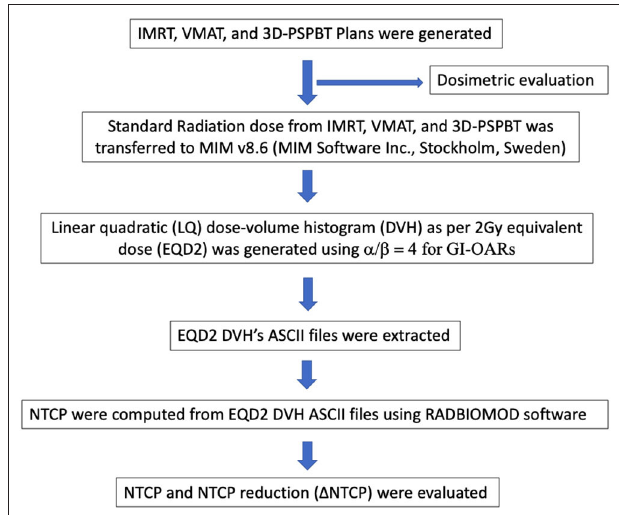
FIGURE 1 | Steps in dosimetric and normal tissue complication probability (NTCP) evaluation of the intensity-modulated radiotherapy (IMRT), volume-modulated arc therapy (VMAT), and 3D-passive scattering proton beam therapy (3D-PSPBT) plans.